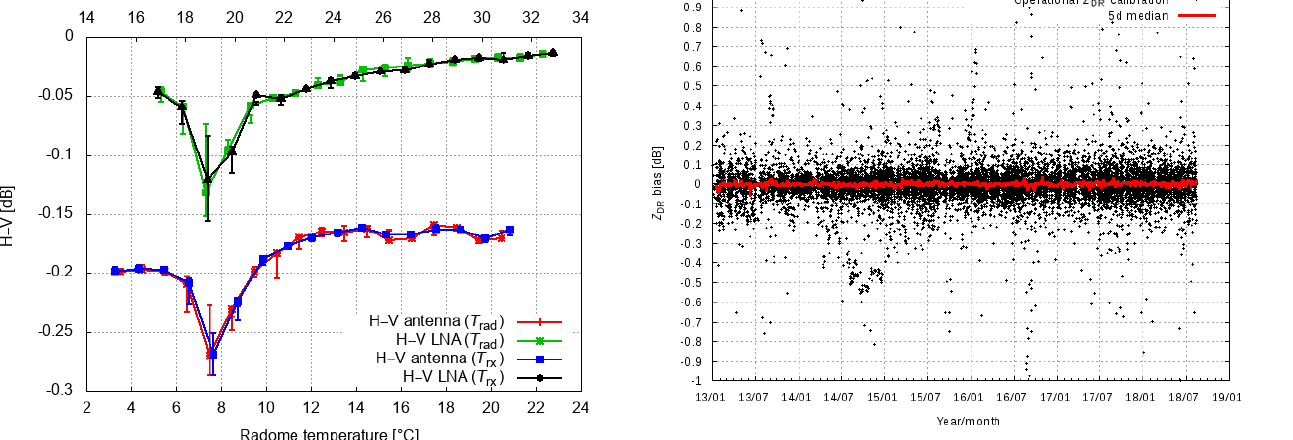
Figure 17. Bin-wise-averaged differential power H–V based on the power samples from the one-point calibration. Either the radome ( T rad ) or the receiver box temperature ( T rx ) is used as a reference. Shown is the median and the first and third quartiles of 1 ◦ wide temperature bins.